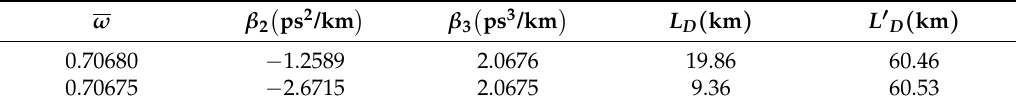
Table 1. Two sets of dispersion data for ω < ω D .